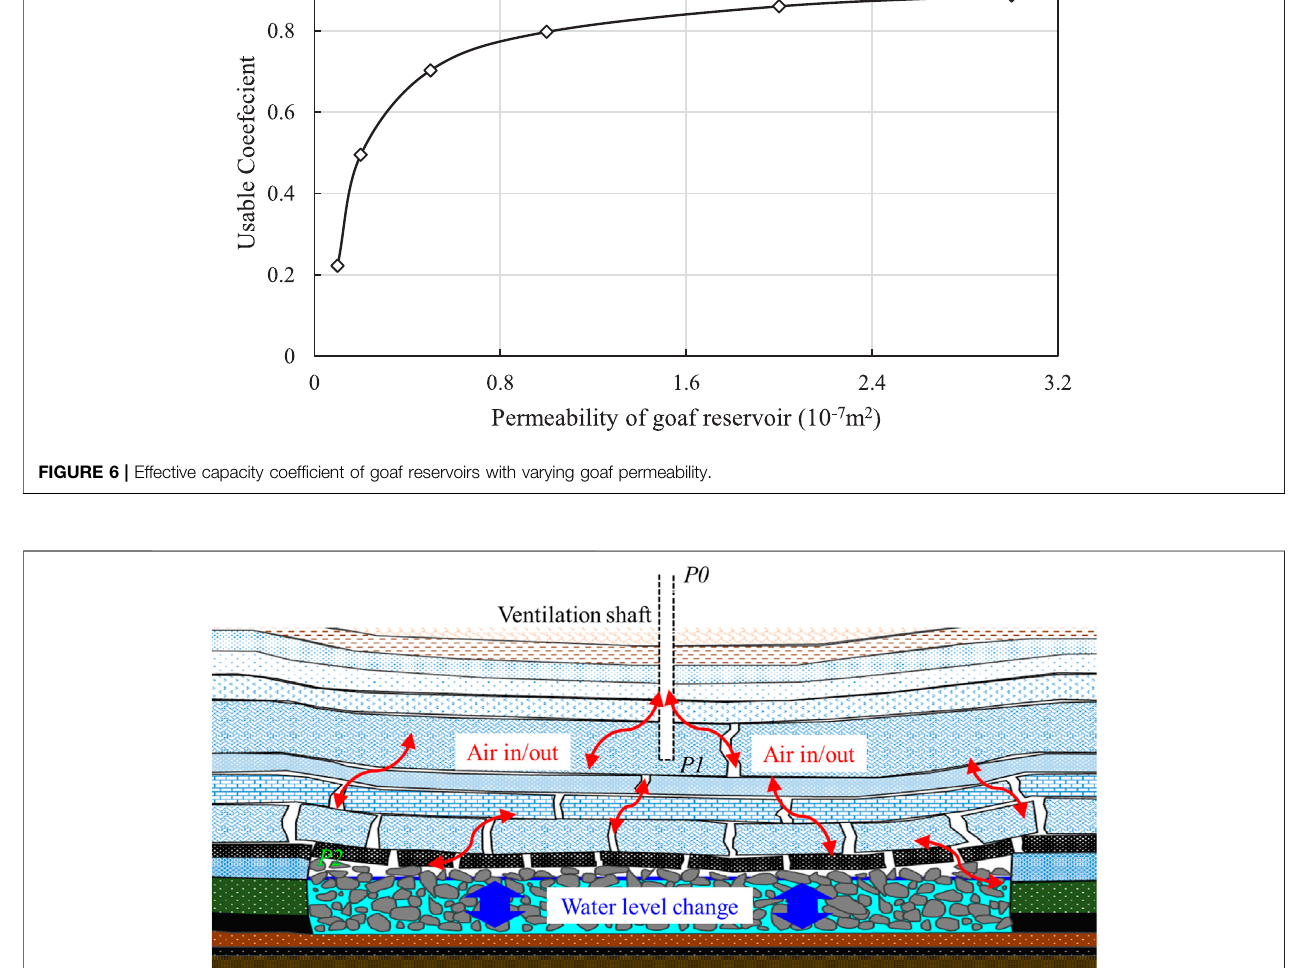
Frontiers in Earth Science |